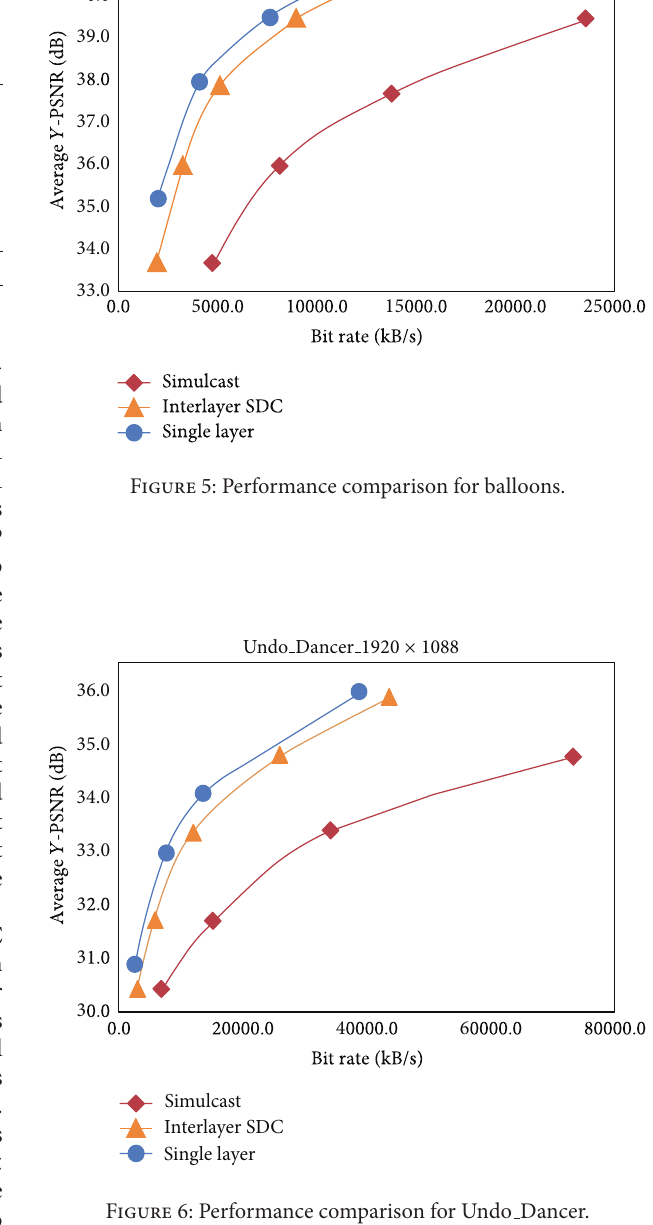
Figure 6: Performance comparison for Undo